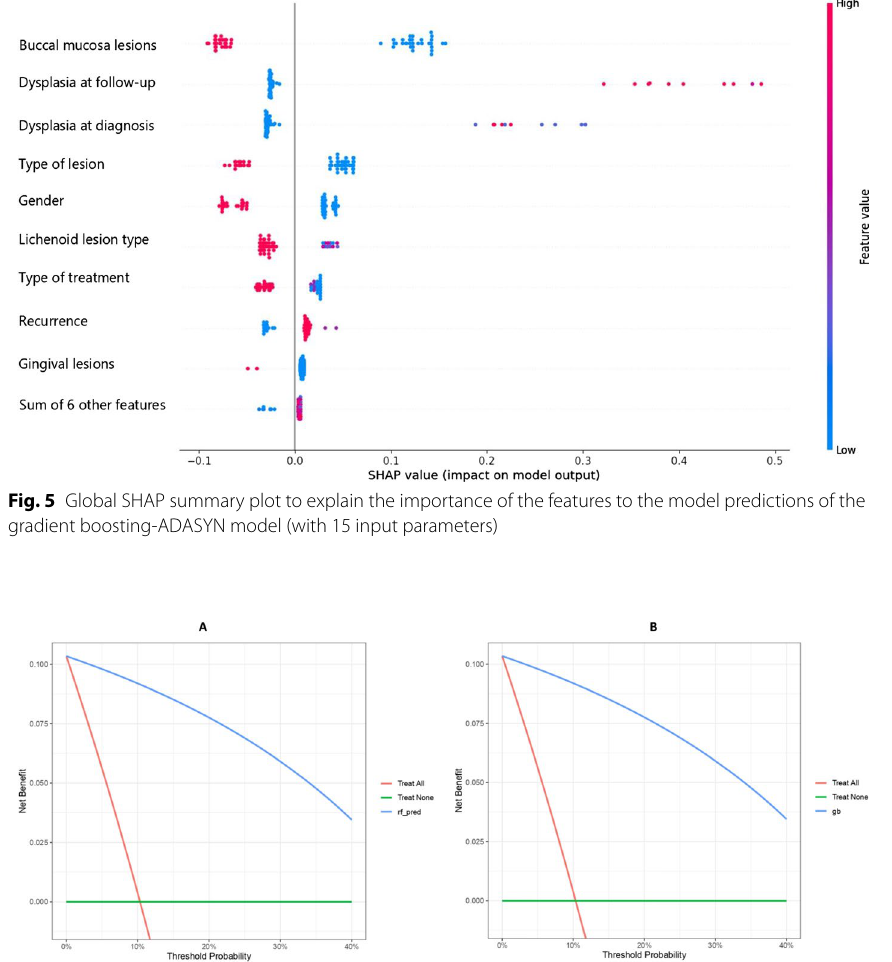
Fig. 6 Decision curves indicating the net benefits of the weighted random forest model ( A ) and gradient boosting‑ADASYN model ( B ) in selecting patients for intervention and close